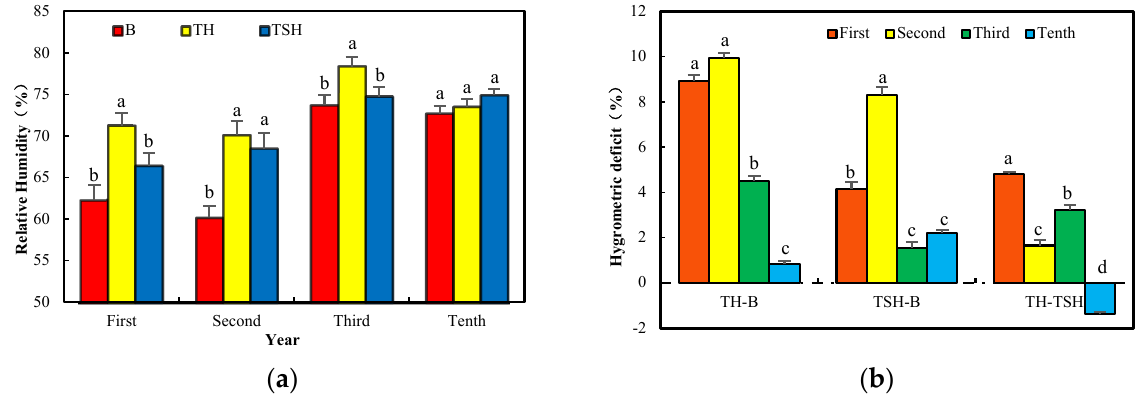
Figure 6. ( a ) Average relative humidity of different vegetation type combinations in different resto- ration years; ( b ) Relative humidity differences of different vegetation type combinations in different restoration years. (a–d): the different letters indicate that there is a significant difference between two vegetation type combinations ( p < 0.05).